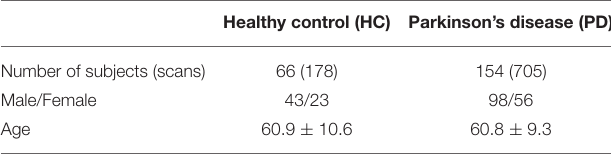
TABLE 1 | Basic statistics of subjects with DTI scans in PPMI